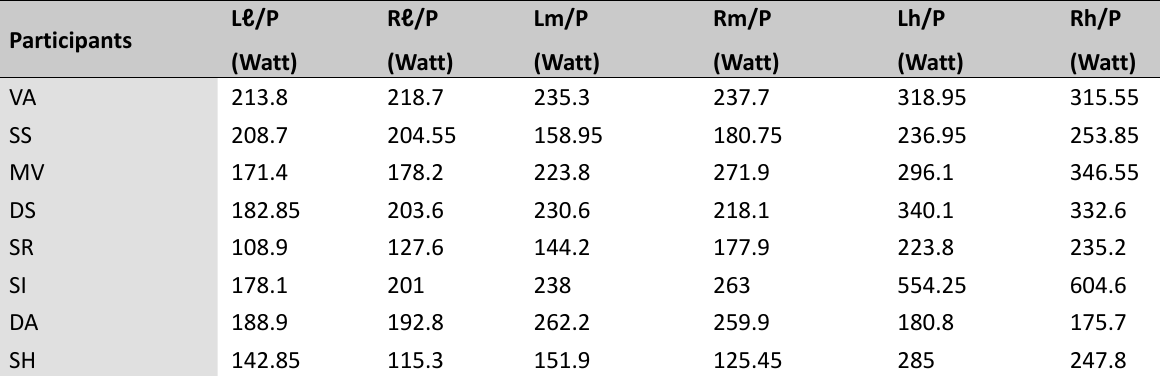
Figure 1. Represents the powers for left Lh / P and right Rh / P leg at an intensity of 85% of HRR. The ordinate shows the power of each measurement and abscissa the number of measurement. Table 2. Peak power for left and right